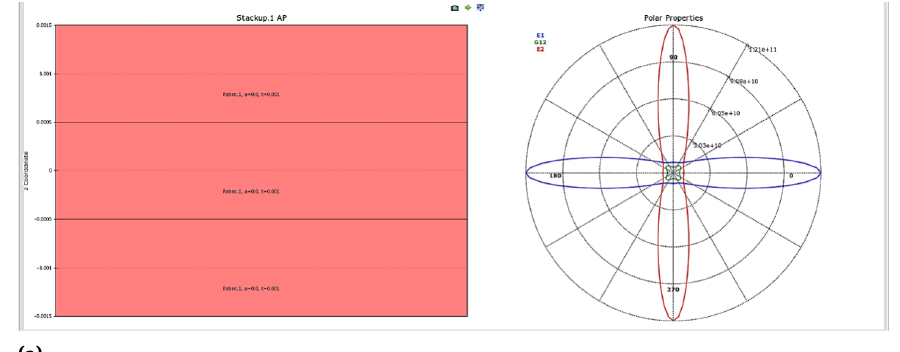
Figure 5: Polar properties. (a) 0 0 0, (b) 0 0 45, (c) 0 0 90, (d) 0 45 0, (e) 0 45 90, (f) 0 90 0, (g) 45 0 0, (h) 45 45 45, (i) 90 0 0, (j) 90 45 0,